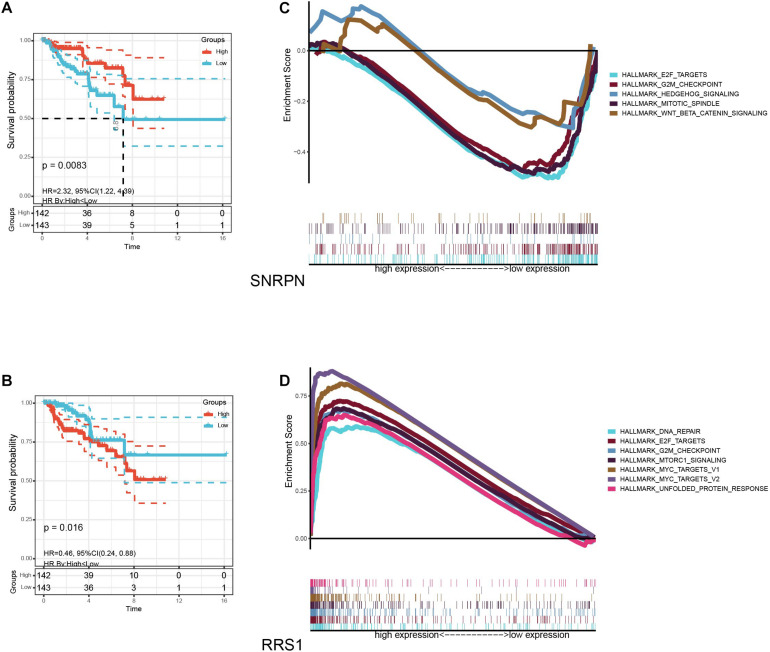
The survival curves and GSEA for samples with high and low expression of SNRPN and RRS1. (A) Kaplan–Meier analysis for overall survival (OS) based on the expression of SNRPN. (B) Kaplan–Meier analysis for overall survival (OS) based on the expression of RRS1. (C) The enriched gene sets in HALLMARK collection by samples with low SNRPN expression. (D) The enriched gene sets in HALLMARK collection by samples with high RRS1 expression.